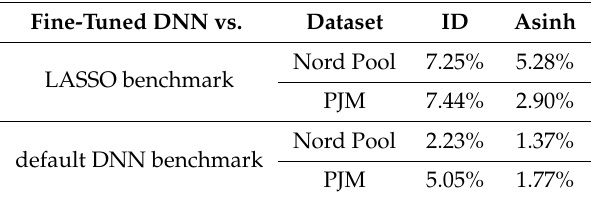
Table 2. Relative improvements in MAE when using the fine-tuned DNN ensemble instead of the benchmark